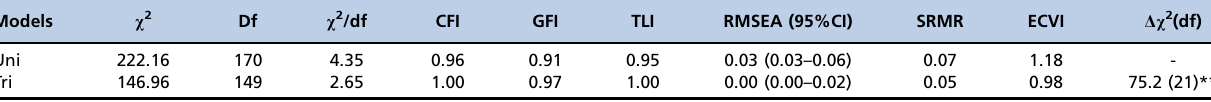
Table 2 - Comparison of PSI factor structure models. Models